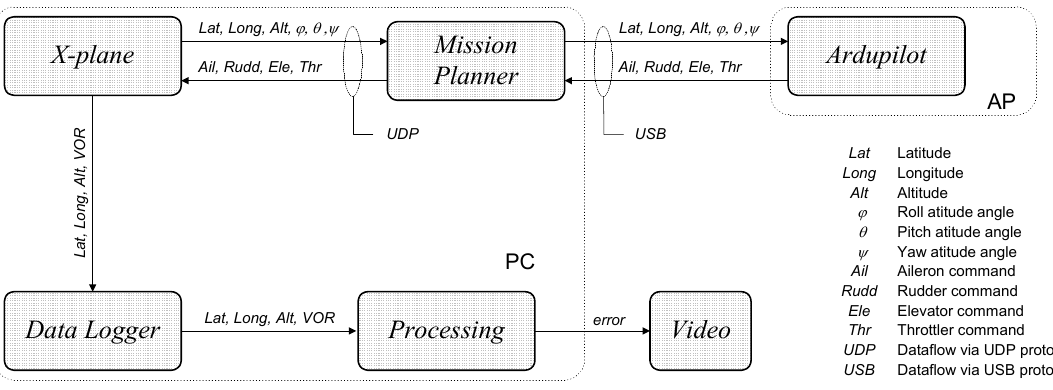
Figure 5. Developed HIL platform. An expansion of the block Processing is depicted in Figure 9.